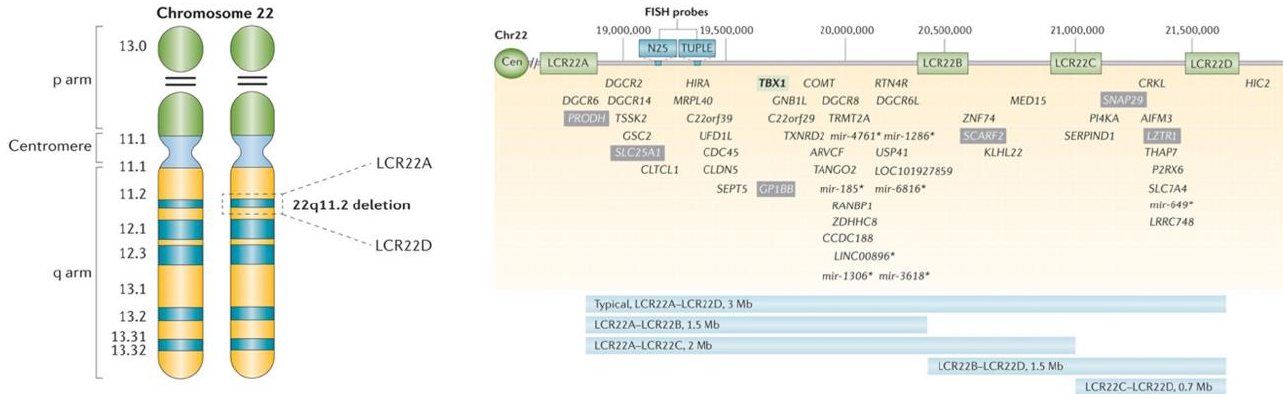
Figure 1. 22q11.2 non-allelic homologous recombination [1]. Diagram of two different types of mei- otic non-allelic homologous recombination events that can occur between low copy repeats on chro- mosome 22 (LCR22s), at spermatogenesis or oogenesis. Rearrangements between LCR22A and LCR22D are indicated (A and D) on each allele (blue versus yellow). Interchromosomal events ( left ) occur between paralogous LCR22s (A and D) in two different alleles owing to >99% sequence iden- tity of direct repeats ( “ X ” shows the crossover of the two chromosomes). The hybrid LCR22 is shown as half yellow and half blue. This process results in a duplication or deletion of the intervening region and genes in resulting gametes. Intrachromosomal recombination events ( right ) result from crossing over (indicated by red “ X ” ) within one allele, resulting in a deletion ( left ) or a ring chro- mosome ( right ); the ring chromosome is not viable [1].